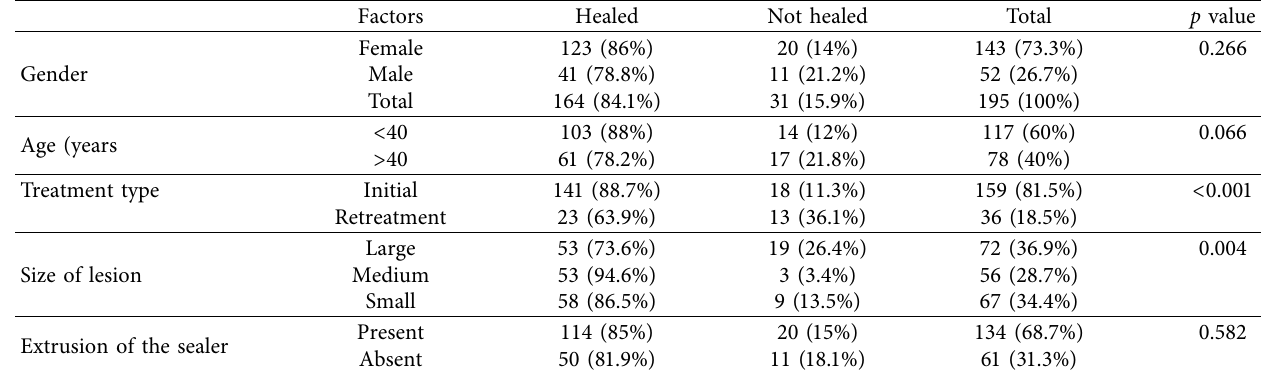
Table 2: Treatment results in related factors and healing outcome.